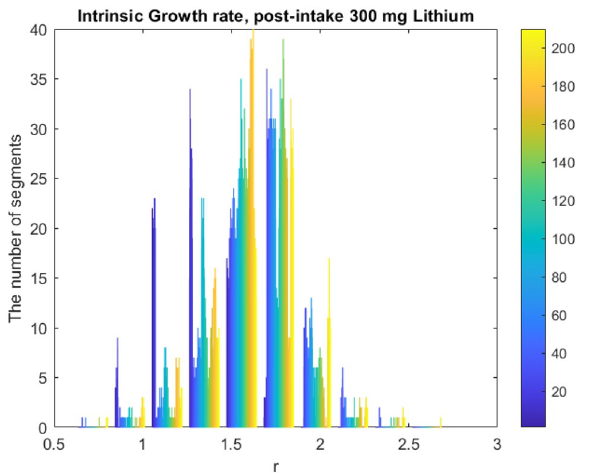
Figure 10. Intrinsic Growth rates for 10 patients each 20 channel and 59-time segments for post-intake (5239-period doubling chaotic regions exist).